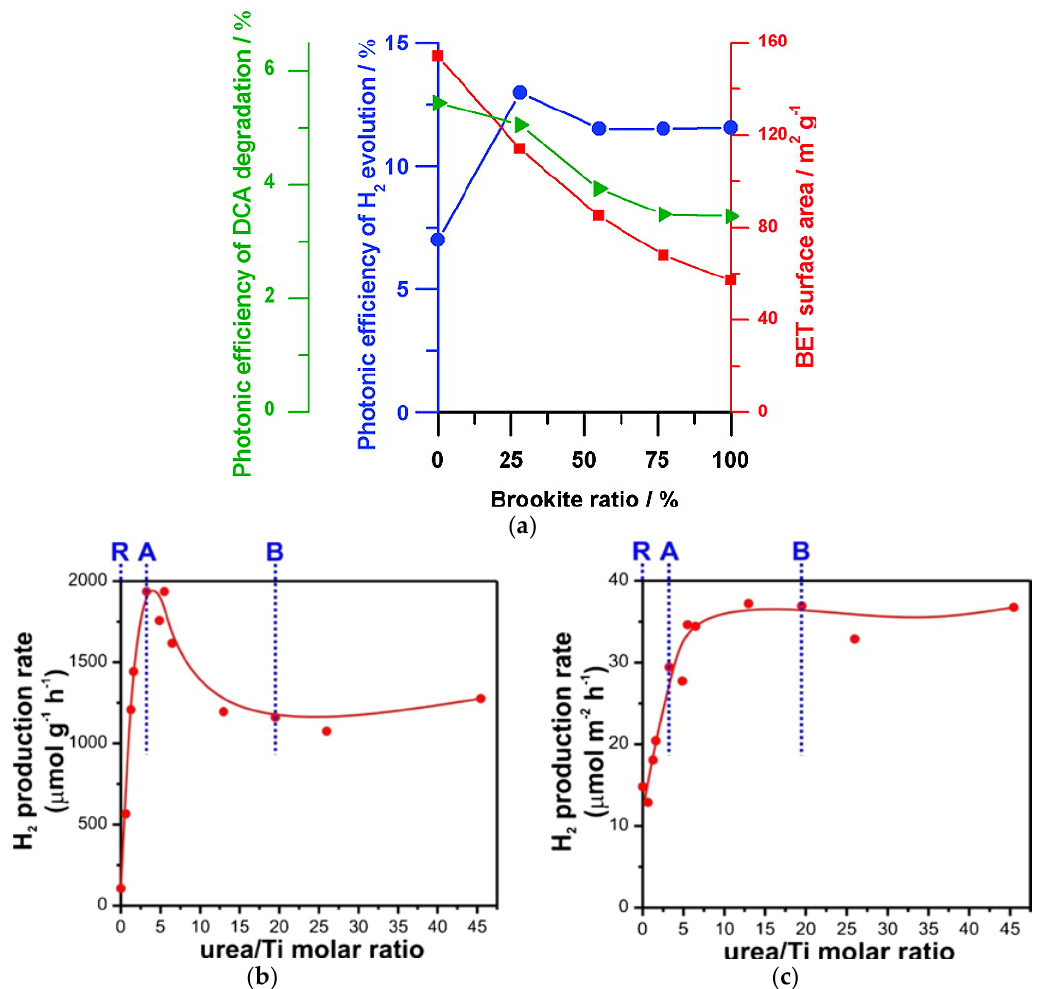
Figure 5. ( a ) Effect of brookite ratio on the photonic efficiency of TiO 2 composites in dicholoracetic acid (DCA) degradation (green triangles) and H 2 production (blue circles). BET surface area (red squares) is reported for comparison with the efficiency trends. Reprinted with permission of reference [82]; ( b ) H 2 production rate by photocatalytic ethanol dehydrogenation over Pt(0.2 wt. %)/TiO 2 prepared using different urea/Ti molar ratios, normalized with respect to the mass of catalysts and ( c ) with respect the surface area. Markers correspond to the urea/Ti molar ratios that allow the preparation of pure phase materials: rutile (R), anatase (A) and brookite (B). Reproduced from reference [21] with permission of the American Chemical Society, 2017.